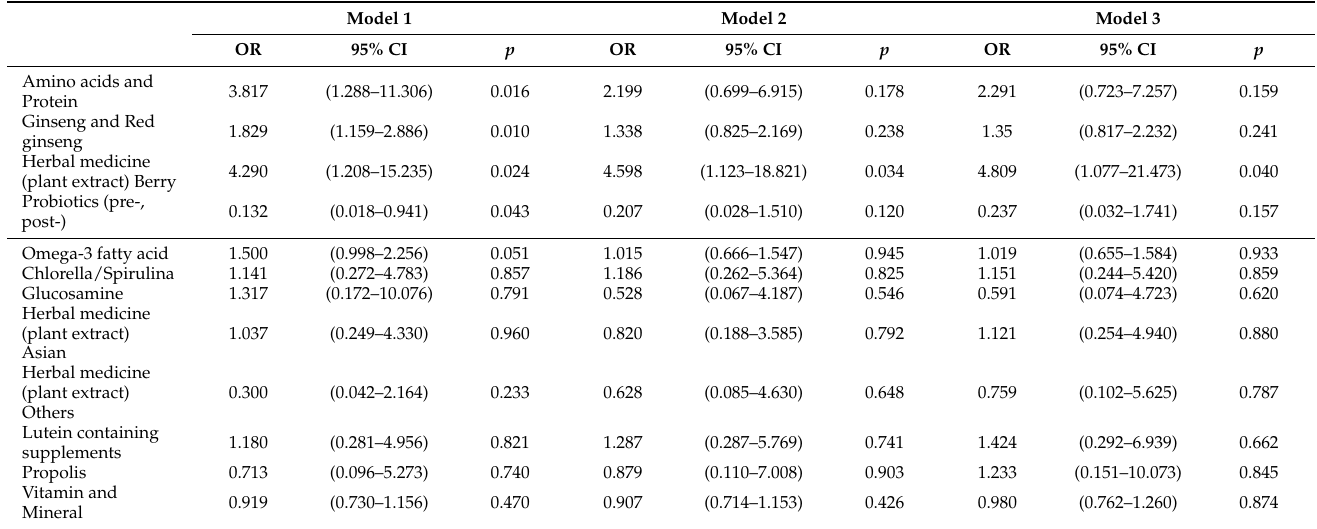
Table 3. Odds ratio (OR) of the incidence of CKD according to take different dietary supplements. Model 1 Model 2 Model